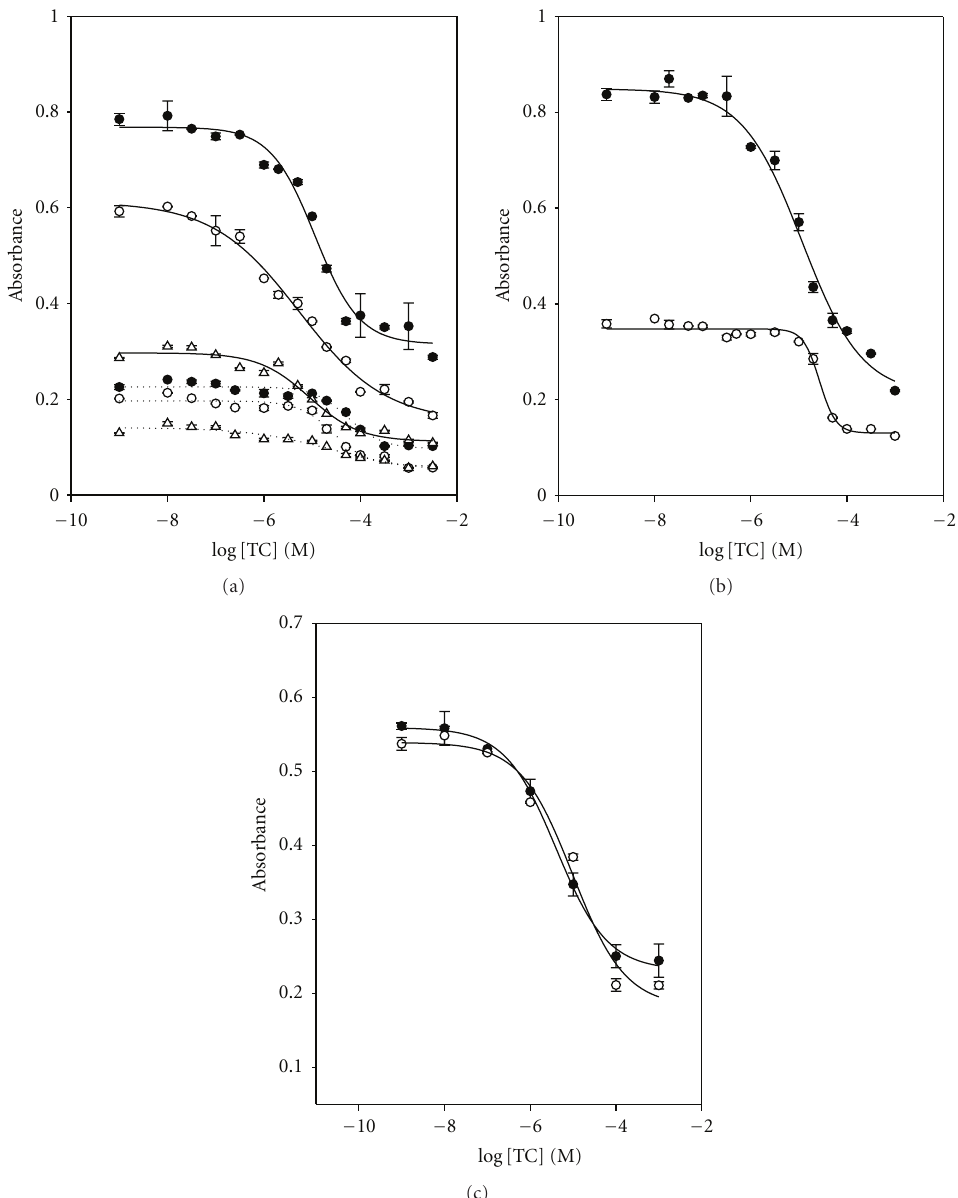
Figure 2: Optimization of TC assay conditions. (a) The concentration of DNA aptamer was ( • ) 0.0250 μ gmL − 1 , ( ◦ ) 0.0188 μ gmL − 1 , and ( (cid:2) ) 0.0125 μ gmL − 1 and the concentration of TC-HRP conjugate was 1 μ gmL − 1 in a solid line and 0.5 μ gmL − 1 in a dotted line. (b) E ff ect of incubation temperature on ELAA performance: ( • ) room temperature and ( ◦ ) 4 ◦ C. (c) Influence of thermal denaturation of DNA aptamer: ( • ) 95 ◦ C, 10 min and ( ◦ ) no